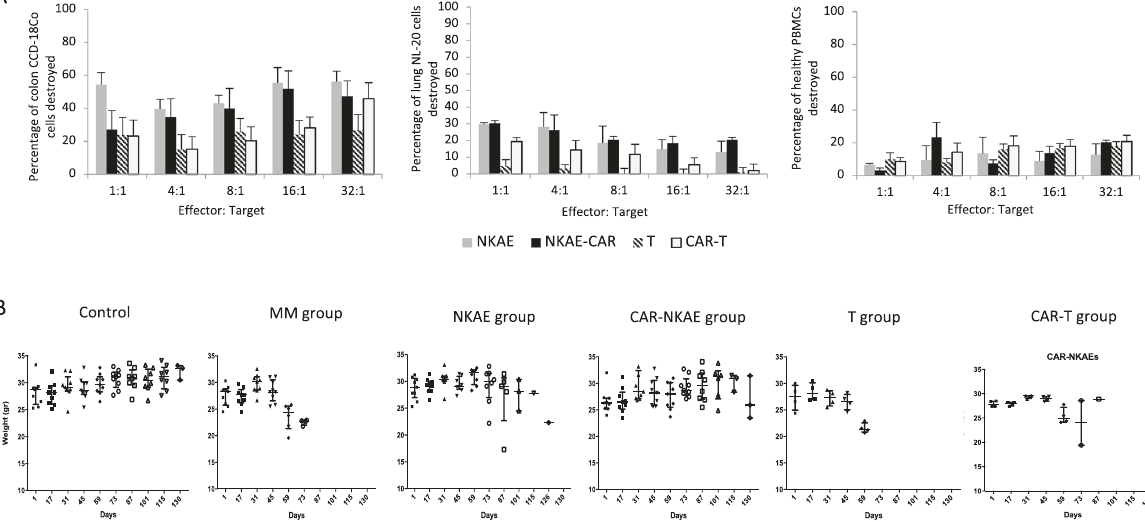
Fig. 8 Toxicity of CAR-expressing cells. A The cytotoxicity of CAR-NKAE and CAR-T cells against healthy tissues (lung, colon, and PBMCs) was evaluated and compared to that of untransduced NKAE and T cells. Results are represented as mean ± SEM of four replicates. B In vivo toxicity was evaluated by monitoring the weights of mice treated during